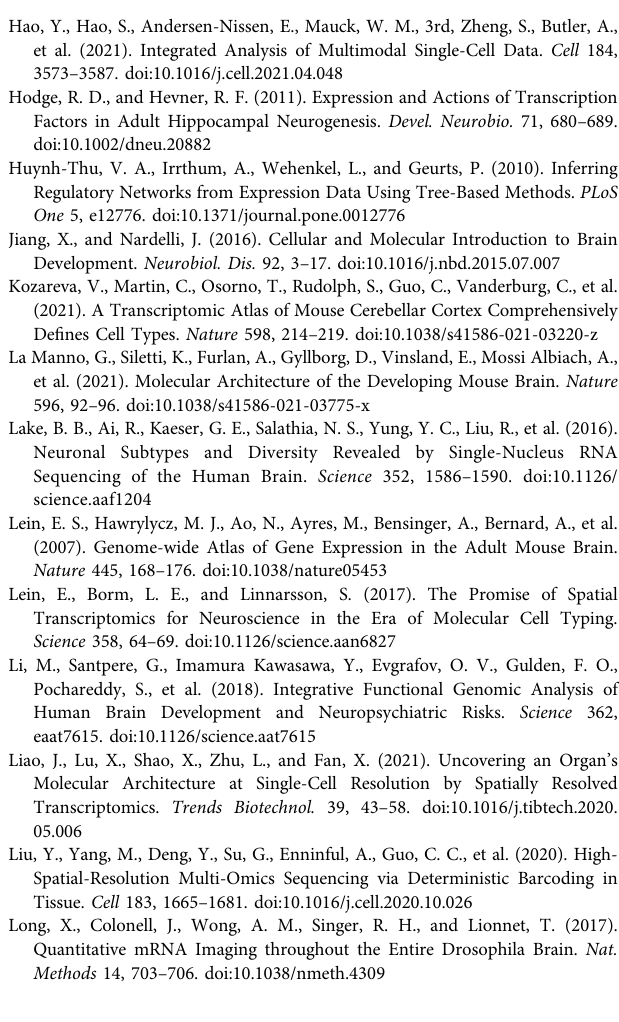
Supplementary Figure S2 | Heatmap of the differential expressed genes of the clusters in Figure 3A